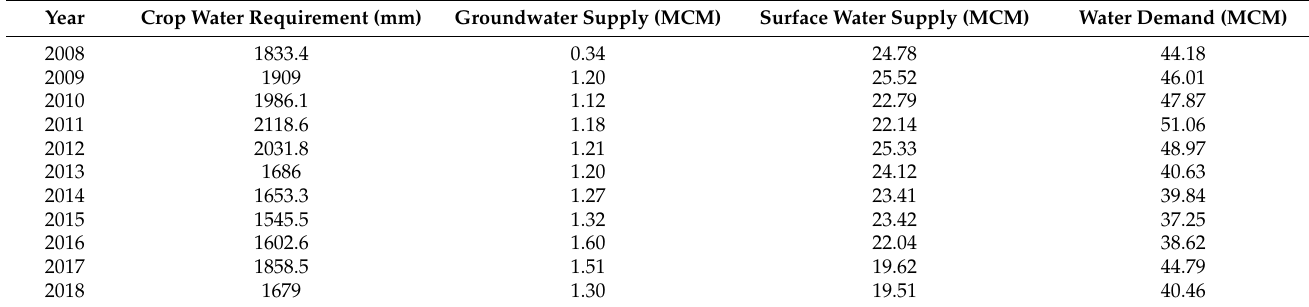
Table 1. Crop water requirement, water supply, and water demand in the Osan watershed. Year Crop Water Requirement